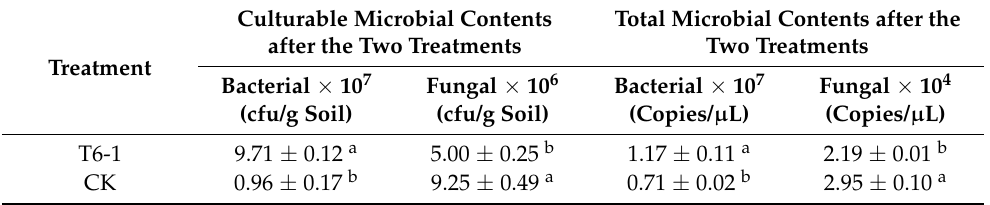
Table 3. Quantity of microorganisms in rhizosphere soils of the two treatments.